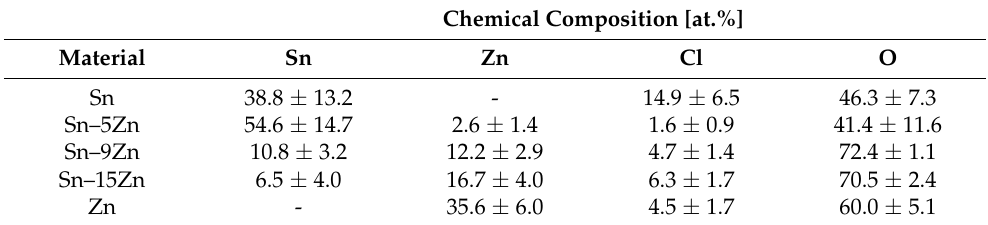
Table 3. Chemical composition of corrosion products formed on alloy surfaces in the HCl solution. Chemical Composition [at.%]